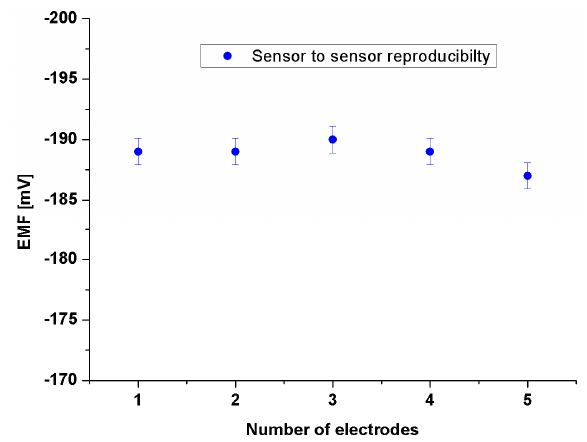
Figure 9. The selective response of the fabricated Glu biosensor in the presence of common interferents at concentrations of 100 µL of 100 mM, glucose, ascorbic acid, urea, or copper ion, respectively.